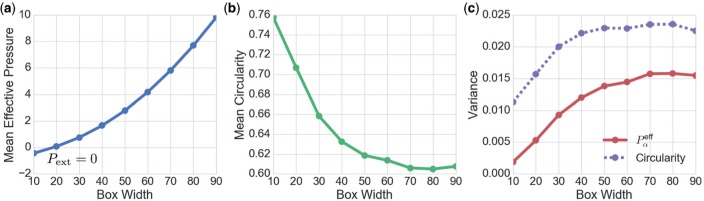
Visualizing the effect of peripheral stress on network packing geometry. 800 cells were simulated in boxes of width \documentclass[12pt]{minimal}
\usepackage{amsmath}
\usepackage{wasysym} 
\usepackage{amsfonts} 
\usepackage{amssymb} 
\usepackage{amsbsy}
\usepackage{upgreek}
\usepackage{mathrsfs}
\setlength{\oddsidemargin}{-69pt}
\begin{document}
}{}$\mathscr{L}=10, 20, \dots, 90$\end{document} leading to \documentclass[12pt]{minimal}
\usepackage{amsmath}
\usepackage{wasysym} 
\usepackage{amsfonts} 
\usepackage{amssymb} 
\usepackage{amsbsy}
\usepackage{upgreek}
\usepackage{mathrsfs}
\setlength{\oddsidemargin}{-69pt}
\begin{document}
}{}$P^{\text{eff}}$\end{document} distributions with means shown in (a). \documentclass[12pt]{minimal}
\usepackage{amsmath}
\usepackage{wasysym} 
\usepackage{amsfonts} 
\usepackage{amssymb} 
\usepackage{amsbsy}
\usepackage{upgreek}
\usepackage{mathrsfs}
\setlength{\oddsidemargin}{-69pt}
\begin{document}
}{}$P_{\text{ext}}=0$\end{document} for a box width of 20. The corresponding means of the distributions of circularities are shown in (b). The variance of the distributions at different box widths are given in (c), for \documentclass[12pt]{minimal}
\usepackage{amsmath}
\usepackage{wasysym} 
\usepackage{amsfonts} 
\usepackage{amssymb} 
\usepackage{amsbsy}
\usepackage{upgreek}
\usepackage{mathrsfs}
\setlength{\oddsidemargin}{-69pt}
\begin{document}
}{}$P_\alpha^{\text{eff}}$\end{document} (solid) and circularity (dashed). Model parameters used were \documentclass[12pt]{minimal}
\usepackage{amsmath}
\usepackage{wasysym} 
\usepackage{amsfonts} 
\usepackage{amssymb} 
\usepackage{amsbsy}
\usepackage{upgreek}
\usepackage{mathrsfs}
\setlength{\oddsidemargin}{-69pt}
\begin{document}
}{}$(\Lambda,\Gamma)=(-0.1,0.1)$\end{document} for which \documentclass[12pt]{minimal}
\usepackage{amsmath}
\usepackage{wasysym} 
\usepackage{amsfonts} 
\usepackage{amssymb} 
\usepackage{amsbsy}
\usepackage{upgreek}
\usepackage{mathrsfs}
\setlength{\oddsidemargin}{-69pt}
\begin{document}
}{}$A_6^*=0.446$\end{document}. Larger box sizes have lower cell density, higher mean \documentclass[12pt]{minimal}
\usepackage{amsmath}
\usepackage{wasysym} 
\usepackage{amsfonts} 
\usepackage{amssymb} 
\usepackage{amsbsy}
\usepackage{upgreek}
\usepackage{mathrsfs}
\setlength{\oddsidemargin}{-69pt}
\begin{document}
}{}$P^{\text{eff}}$\end{document}, lower mean circularity and greater variability. (Colour in online.)